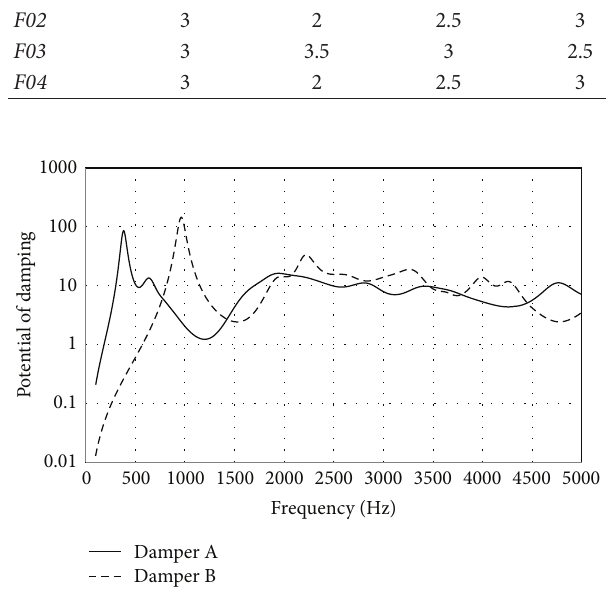
Figure 13: Damping potential of two dampers designed for broad- band noise.